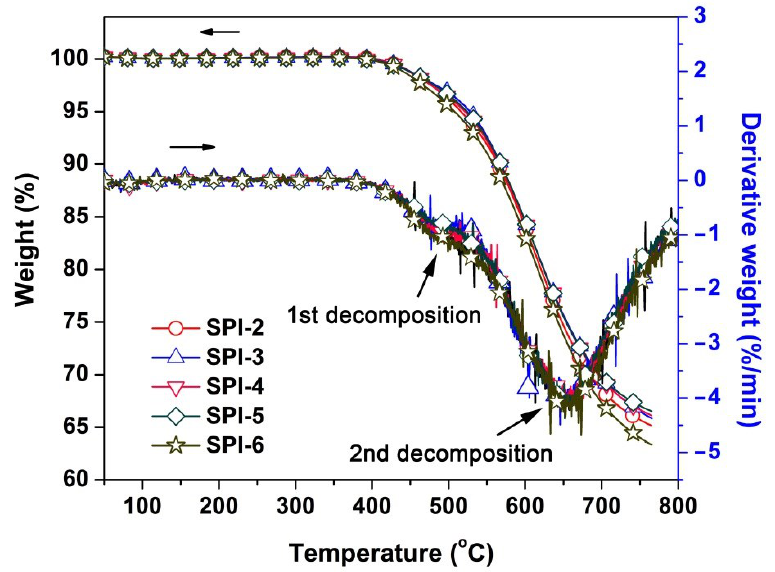
Figure 8. TGA and DTG curves of SPI NFMs. Table 3. Thermal properties of PI and